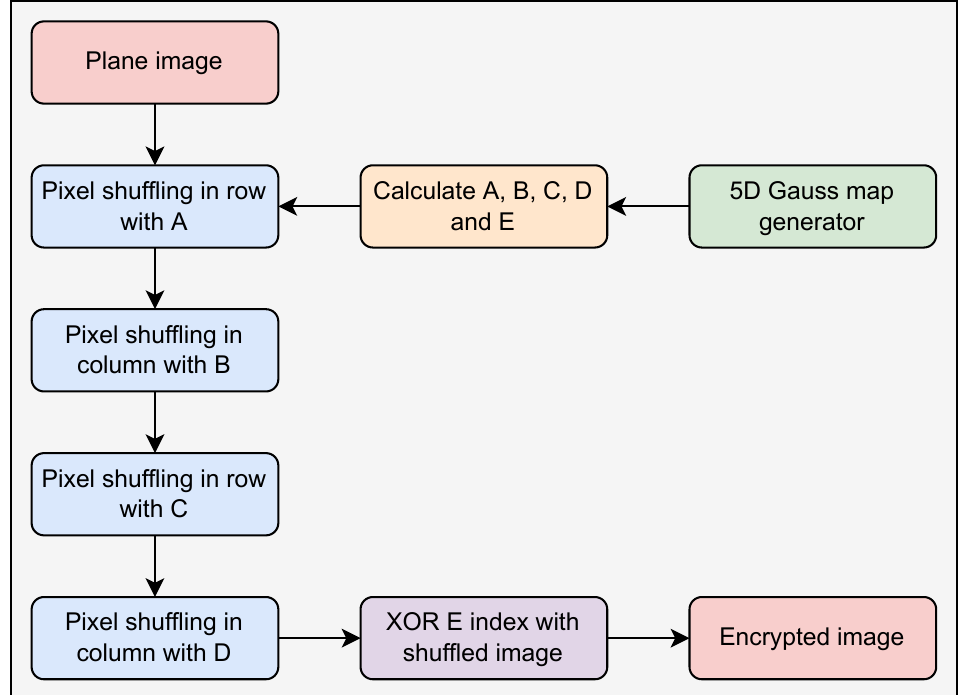
Figure 6. Flow diagram of the encryption process with a 5D Gauss